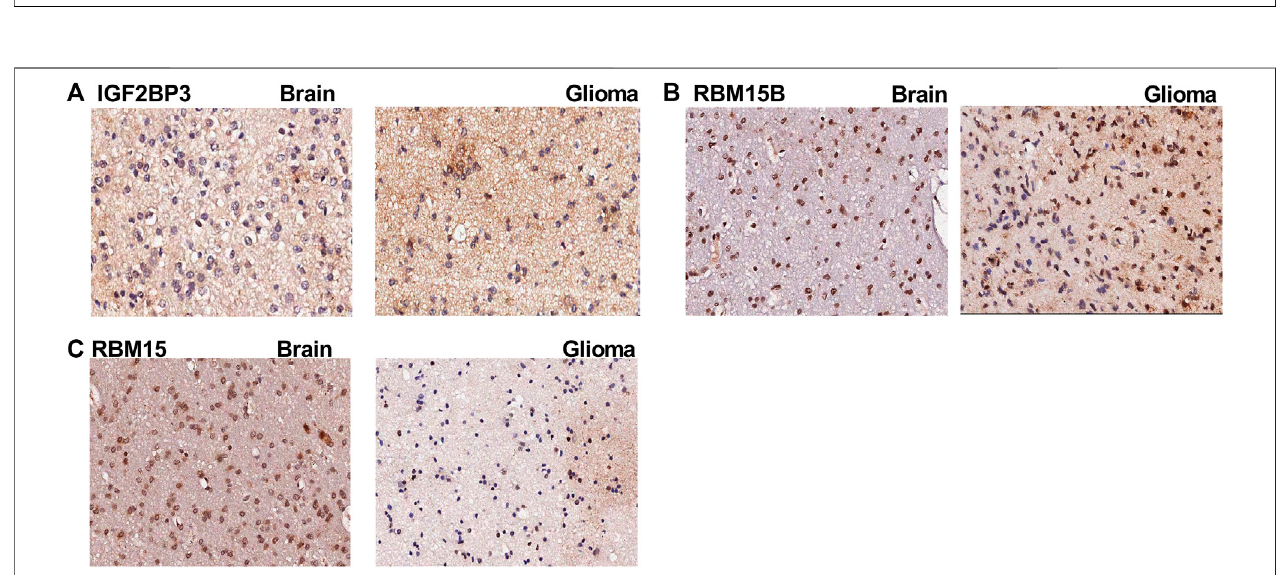
FIGURE 10 | The immunohistochemistry images for m6A genes. (A) The immunohistochemistry (IHC) images for IGF2BP3 in para-tumoral and glioma tissue; (B) The IHC images for RBM15B in para-tumoral and glioma tissue; (C) The IHC images for RBM15 in para-tumoral and glioma tissue.